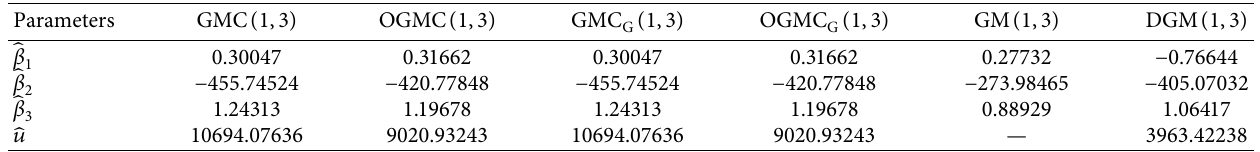
Table 8: Estimated parameter values of six competing models in case three. Parameters